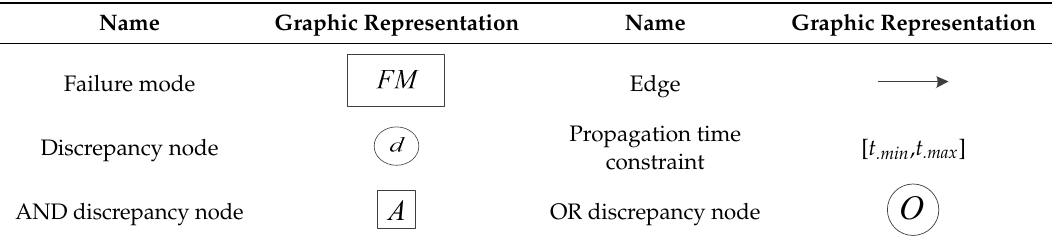
Table 1. Descriptions of the timed failure propagation graph (TFPG) element.